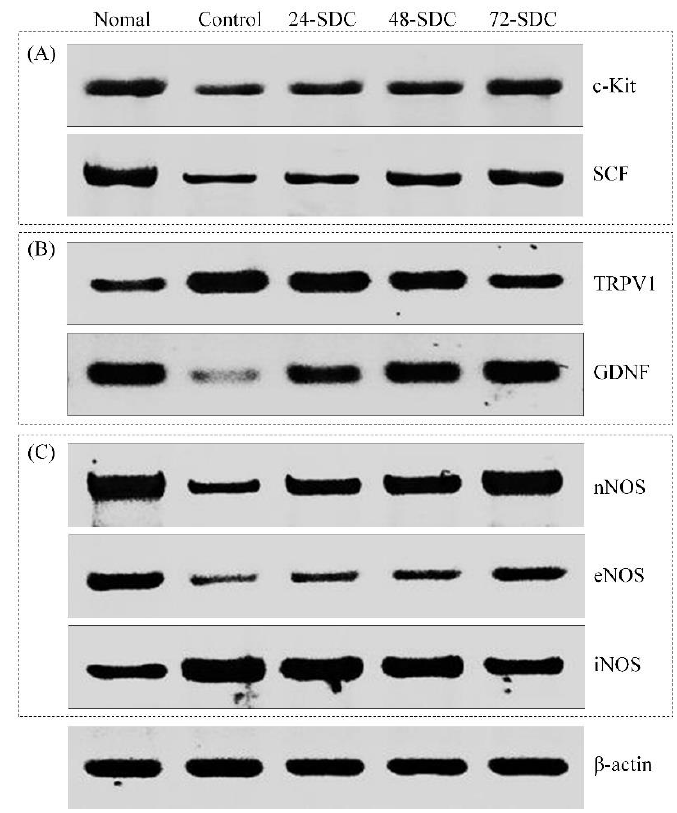
Figure 7. Protein expression levels of ( A ) c-Kit and SCF ; ( B ) TRPV1 and GDNF ; ( C ) nNOS , eNOS , and iNOS in the small-intestine tissue of mice. 24-SDC: 24-h-fermented Shuidouchi; 48-SDC: 48-h-fermented Shuidouchi; 72-SDC: 72-h-fermented Shuidouchi.